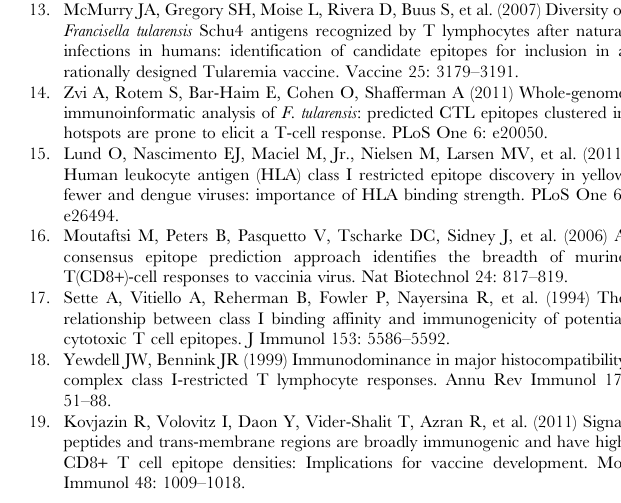
Table S3 List of 92 peptides selected from the high affinity- based approach, having IC50 values , = 10 nM. The affinity provided is the IC 50 value predicted for a particular responder sequence by the NetMHC3.0 program. The gi number and annotation of the source protein are according to the F. tularensis holarctica LVS sequence deposited at the NCBI (GenBank accession AM233362); (a) Responders are indicated by their magnitude of T-cell response as follows number of spots/million cells) is: L (Low): 5–20; M (medium) - 20–32; H (high) - 33 and above. Table S4 List of 370 peptides (262 selected by the cluster-based approach - indicated as ‘‘clu’’ and 108 selected by the affinity- based approach - indicated as ‘‘aff’’) tested in the BALB/c screen. The affinity provided is the IC 50 value predicted for a particular responder sequence by the NetMHC3.0 program. The gi number and annotation of the source protein are according to the F. tularensis holarctica LVS sequence deposited at the NCBI (GenBank accession AM233362); (a) Responders are indicated by their magnitude of T-cell response as follows (number of spots/ Table S5 The list of peptides provides the compiled data of responders from previously identified responders (Subsets I and